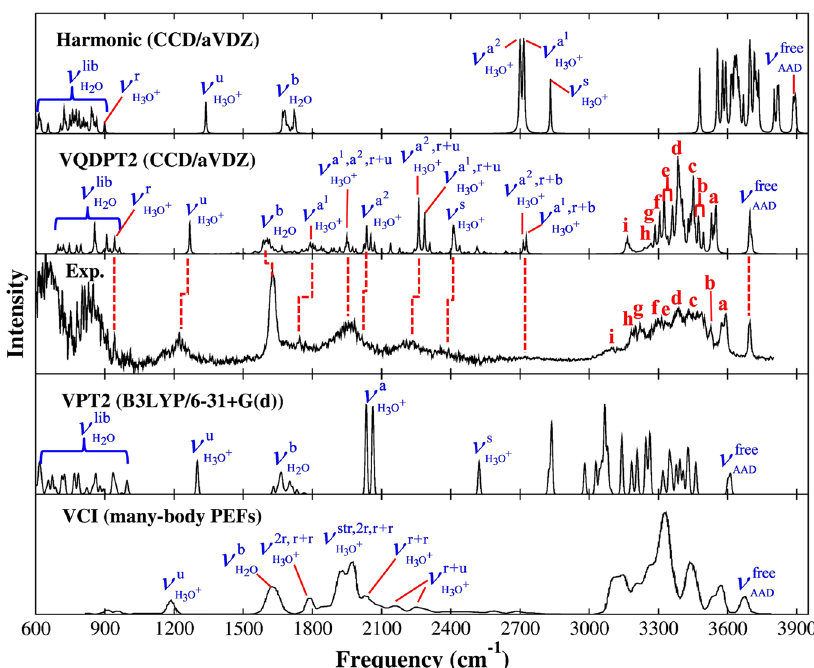
Fig. 2 IR spectra of the H + (H 2 O) 21 cluster. IR spectra of the H + (H 2 O) 21 cluster obtained by the harmonic approximation and VQDPT2 method based on the fragment-based CCD/aug-cc-pVDZ approach, as compared to the experiment 10 and the previous calculations by VPT2 based on B3LYP/6-31 + G(d) 30 and VCI based on the many-body PEFs 36 . The fundamental excitations of H 3 O + are denoted ν r (frustrated rotation), ν u (umbrella vibration), ν a 1 H 3 O þ H 3 O þ H 3 O þ and ν a 2 H (asymmetric O-H stretching), ν s H (symmetric O-H stretching), and those of H 2 O are denoted ν lib H (libration), ν b H (bending), ν free AAD (dangling 2 O 2 O 3 O þ 3 O þ O-H stretching of AAD), and ( a – i ) (O-H stretching). The resonance states between the fundamental excitation of asymmetric O-H stretching and the combination tones (r + u and r + b) are denoted ν a 1 ; a 2 ; r þ u , ν a 1 ; r þ u , ν a 2 ; r þ u , ν a 1 ; r þ b , and ν a 2 ; r þ b , where r , u , and b represent the frustrated rotation, the umbrella H 3 O þ H 3 O þ H 3 O þ H 3 O þ H 3 O þ vibration, and the HOH bending of H 3 O + , respectively. The harmonic and VQDPT2 spectra are broadened using Lorentz functions with the full-width at half-maximum (FWHM) of 5 cm − 1 . The raw stick spectrum is shown in Supplementary Fig.